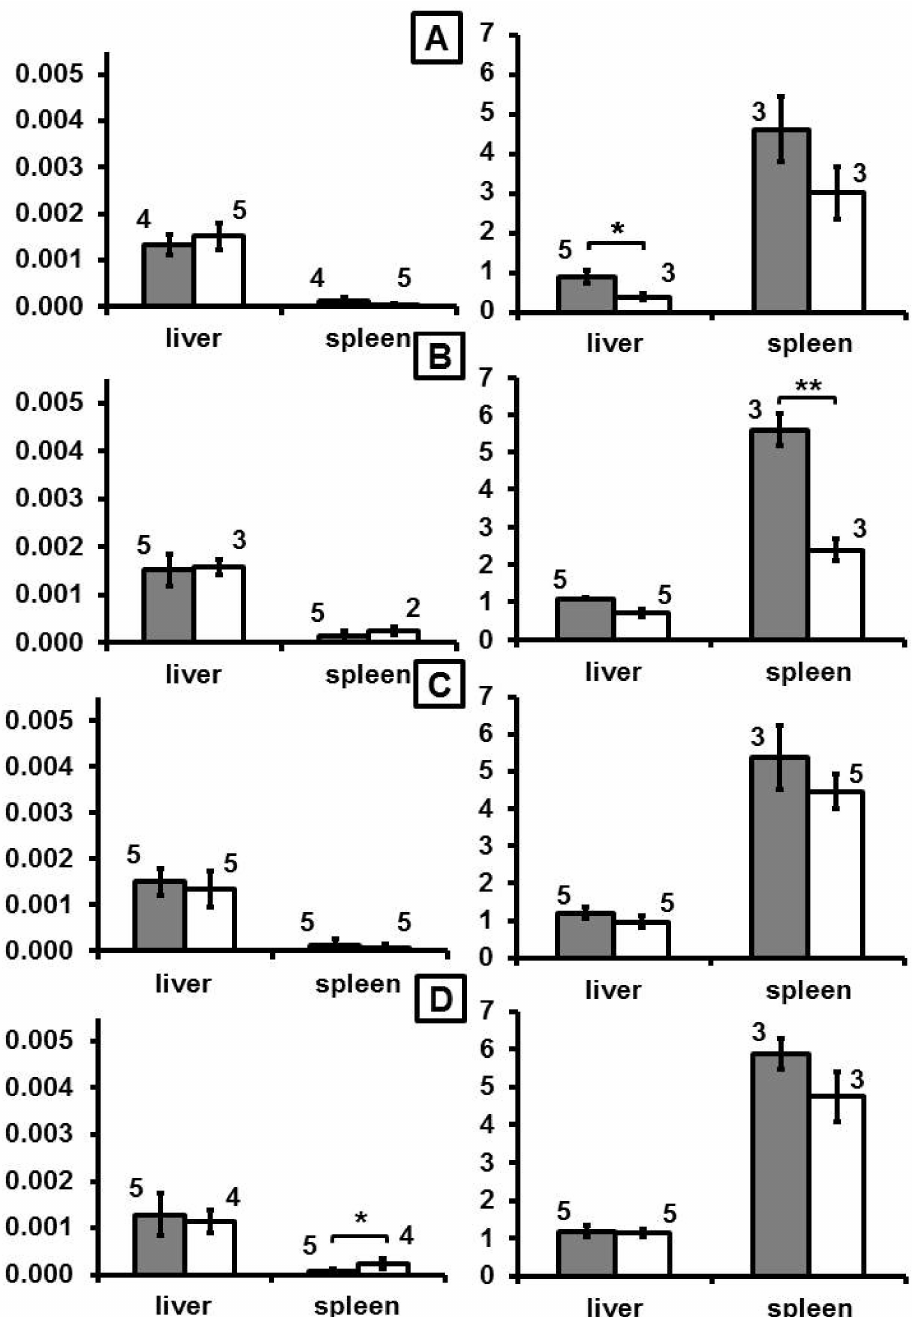
Figure 2. The time-dependent organ distribution fluorescence of the dye DY-555 attached to the MNP and the iron concentration in the organs. ( A )–( D ): 0, 2, 4, and 6 months after MNP injection in mice, respectively. Left panel: semiquantitative fluorescence intensity (em: 573 nm, arbitrary units per s, n = 5); right panel: iron content (mg iron per g tissue, n = 3). Gray and white bars: after MNP injection or native controls, respectively. Nude mice were injected with dually-labelled MNP-D(DY-730)-PEG-5kDa(DY-555) (200 µ mol Fe / kg body weight). At the defined time points, animals were killed and semiquantitative fluorescence intensities of each fluorochrome in excised organs was determined. ROI: 916 pixels, n = 5, mean and standard deviation of the mean, * p < 0.05; ** p < 0.01; Tukey post-hoc